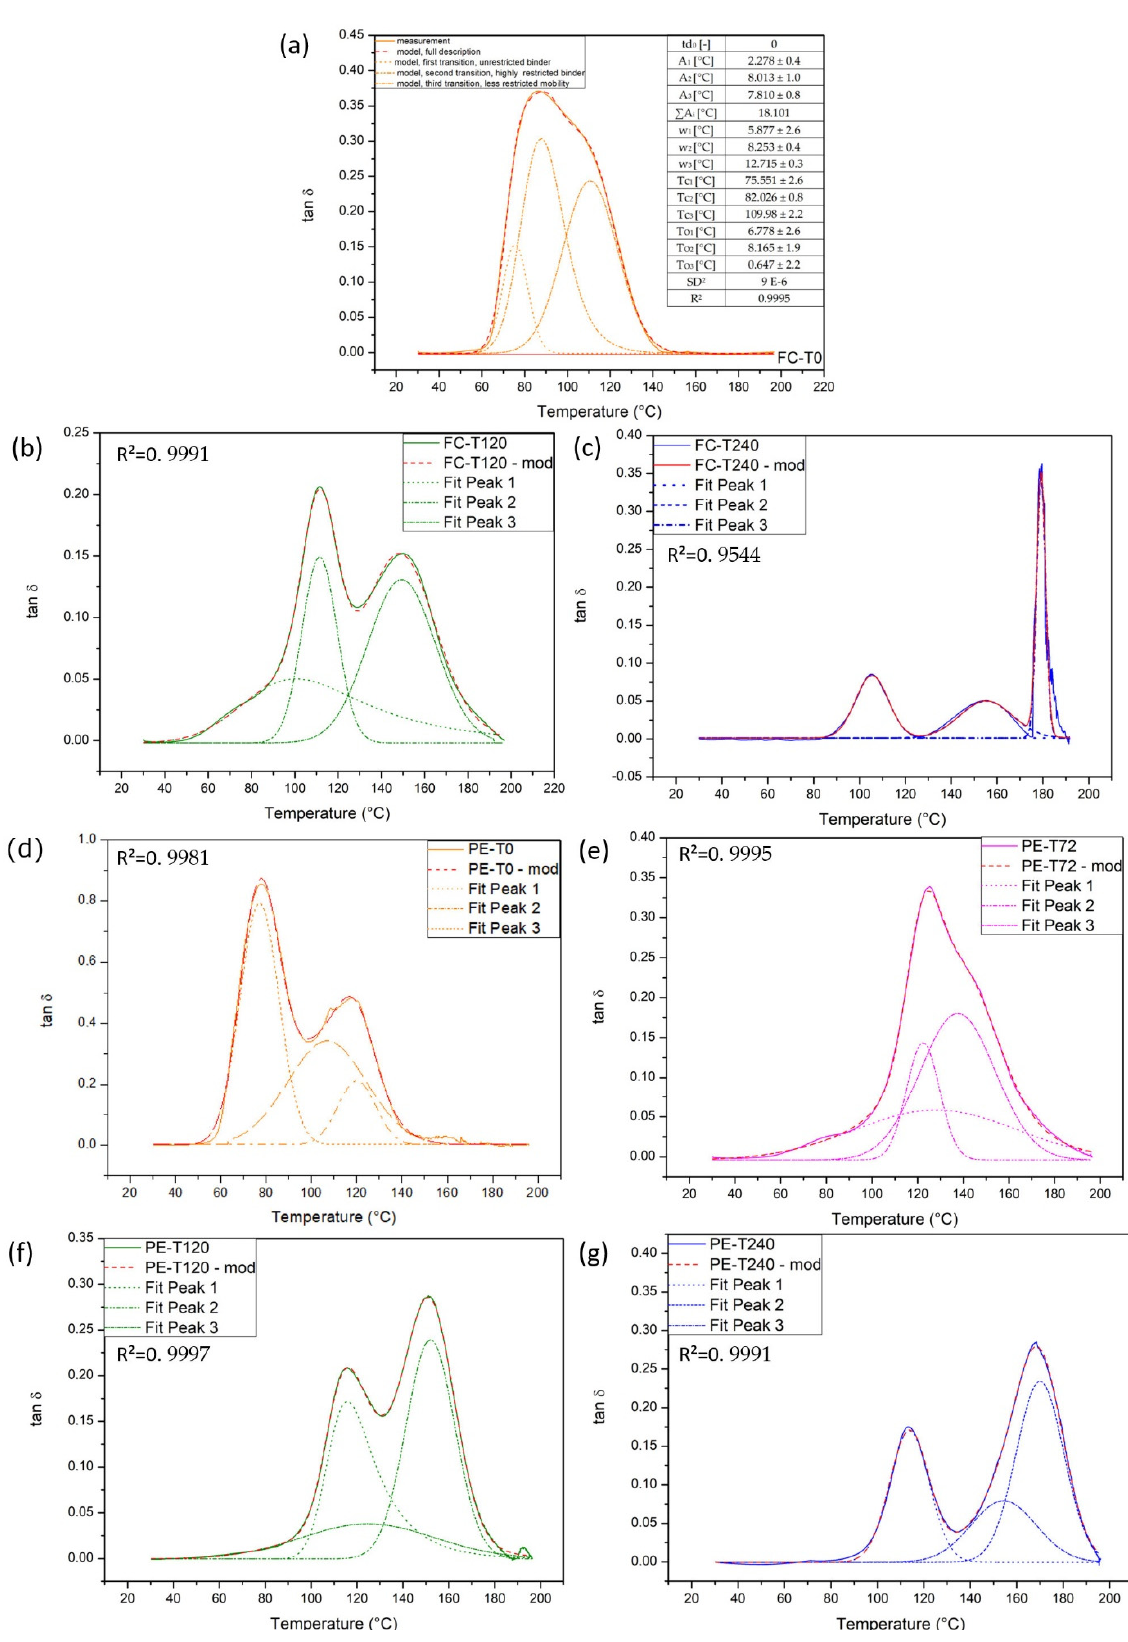
Figure 11. Description of loss factors of the plain epoxy and fique fabric composites in different aging conditions with three EMG functions. (The solid curves represent the original data and the dashed lines are relative to the result after multi-peak resolution.) ( a ) FC-T0; ( b ) FC-T120; ( c ) FC-T240; ( d ) PE-T0; ( e ) PE-T72; ( f ) PE-T120; and ( g ) PE-T240.